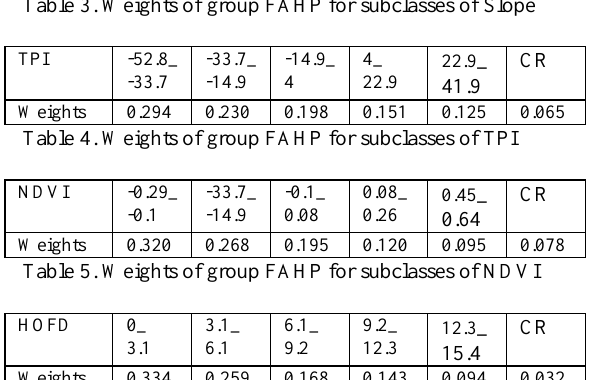
Table 3. Weights of group FAHP for subclasses of Slope